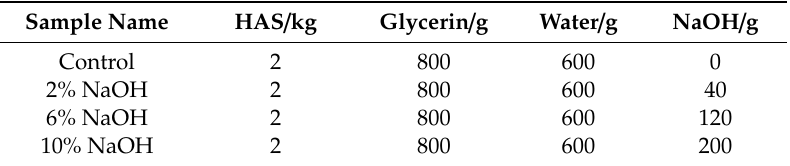
Table 1. Raw material ratios of HAS film with di ff erent NaOH